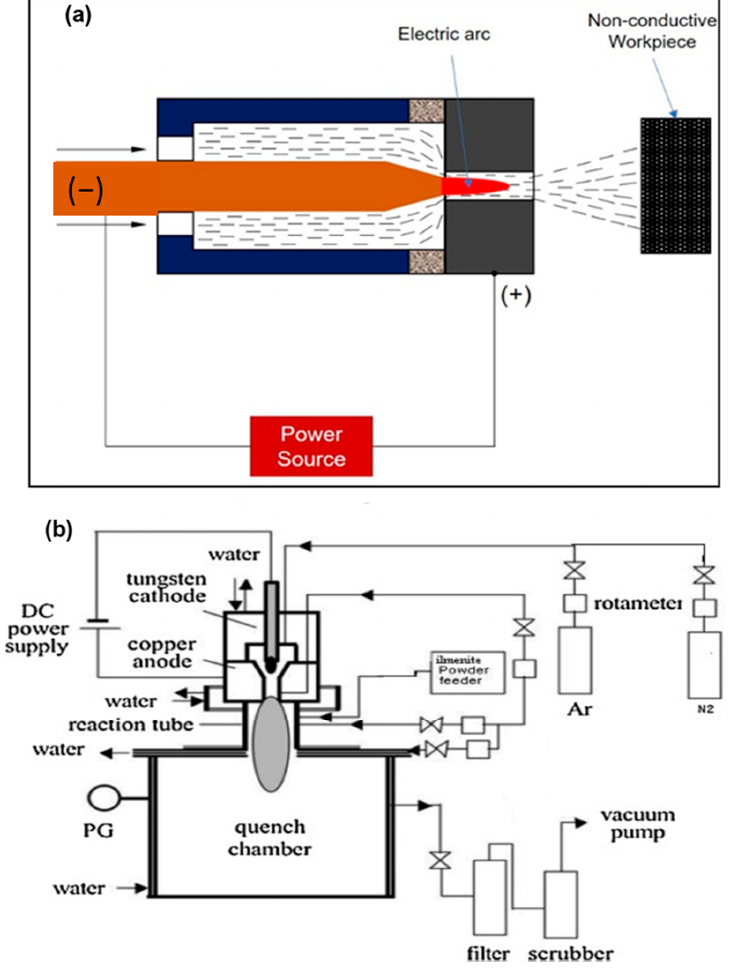
Figure 3. Schematic diagrams of: ( a ) nontransferred system; ( b ) nontransferred plasma reactor. Re- printed from [21] with permission from Elsevier 1989.